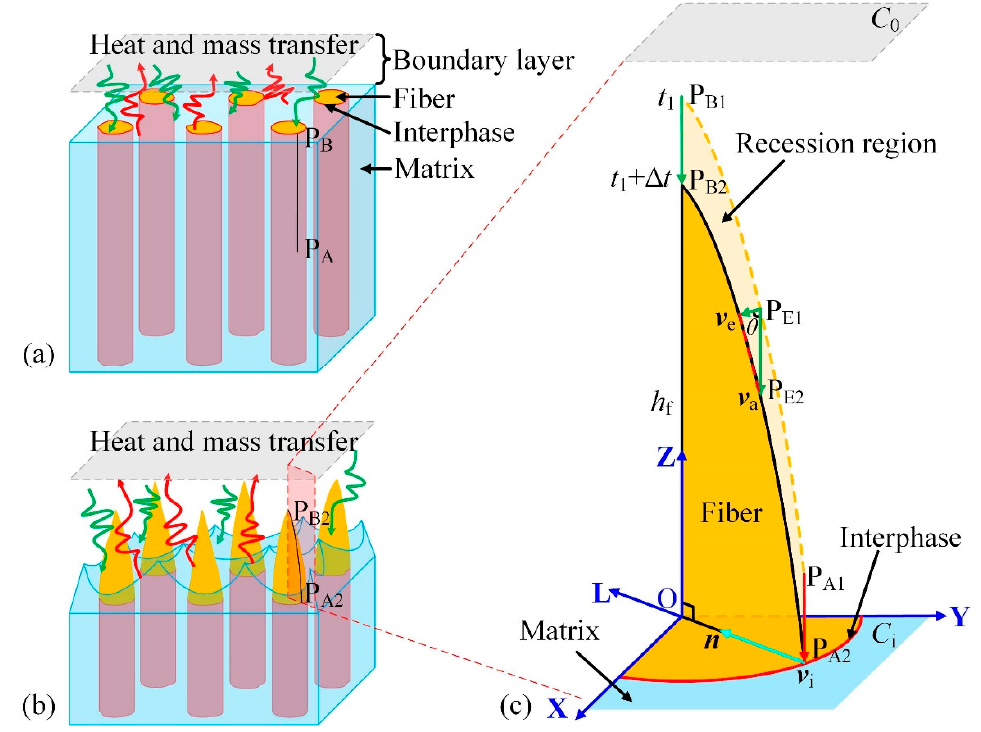
Figure 3. Schematic diagram of composites’ surface morphology evolution, ( a ) initial microstructure of the material; ( b ) steady-state ablation morphology; ( c ) velocity relationship of the steady-state ablation morphology.